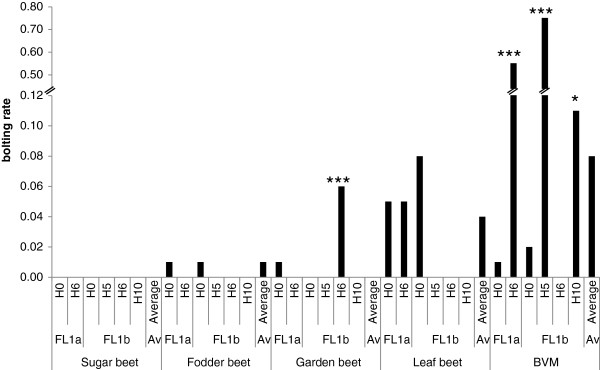
BvFL1 haplotype effect on bolting rate before winter. Graphic representation of the effect of BvFL1 haplotypes of the amplicons FL1a and FL1b on bolting rate before winter in five B. vulgaris forms. * or *** mark non-reference haplotypes with a significantly different bolting rate from reference haplotypes FL1a_H0 or FL1b_H0 (P < 0.05 or P < 0.0001, respectively); BVM = B. vulgaris ssp. maritima.